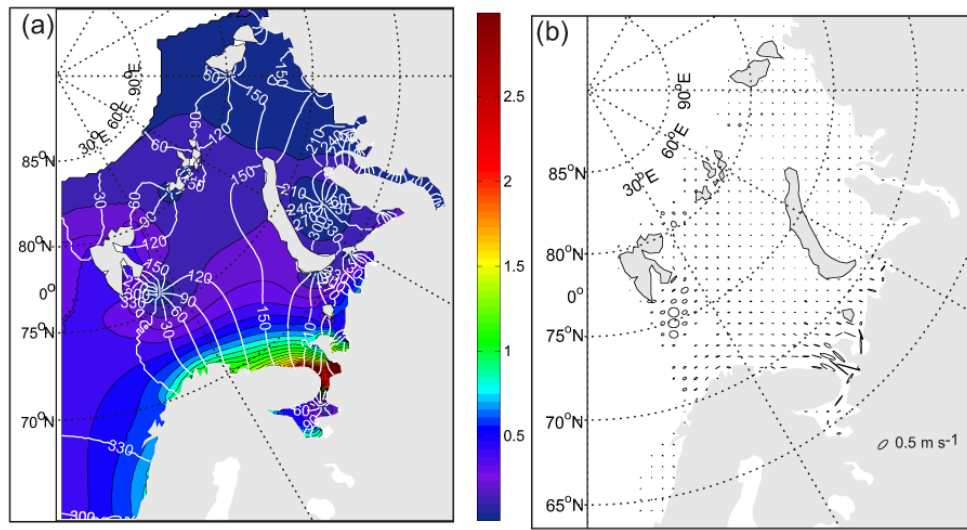
Fig. 3. (a) Contour plot of the M2 tidal elevation amplitude in meters (color with black contours. Contours are spaced every 0.1m between 0 and 1m and spaced every 0.5m from 1–3m) and phase in degrees (white contours). (b) M2 tidal